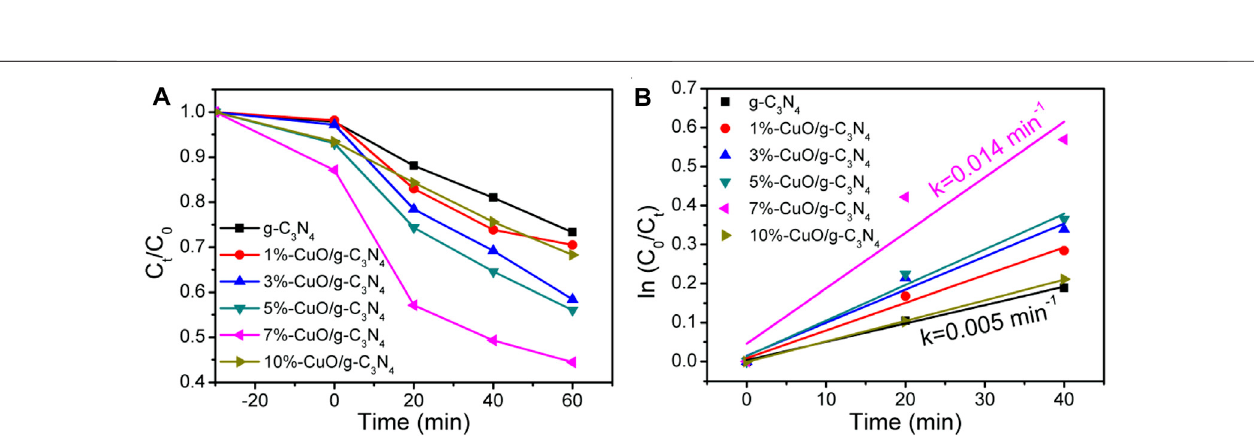
FIGURE 7 | Photoactivities for the decomposition of tetracycline hydrochloride using g-C 3 N 4 and CuO/g-C 3 N 4 as photocatalysts.